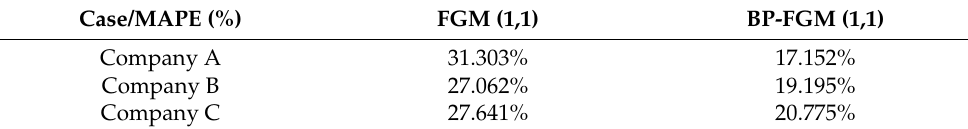
Table 3. The summary of experiment errors by using the FGM and BP-FGM models.